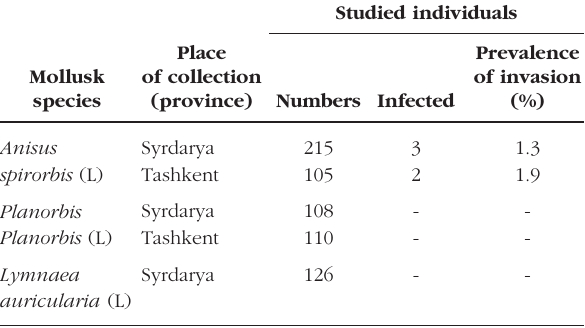
Table II. – Infection of mollusks by cercariae of Dendritobilharzia under natural conditions.